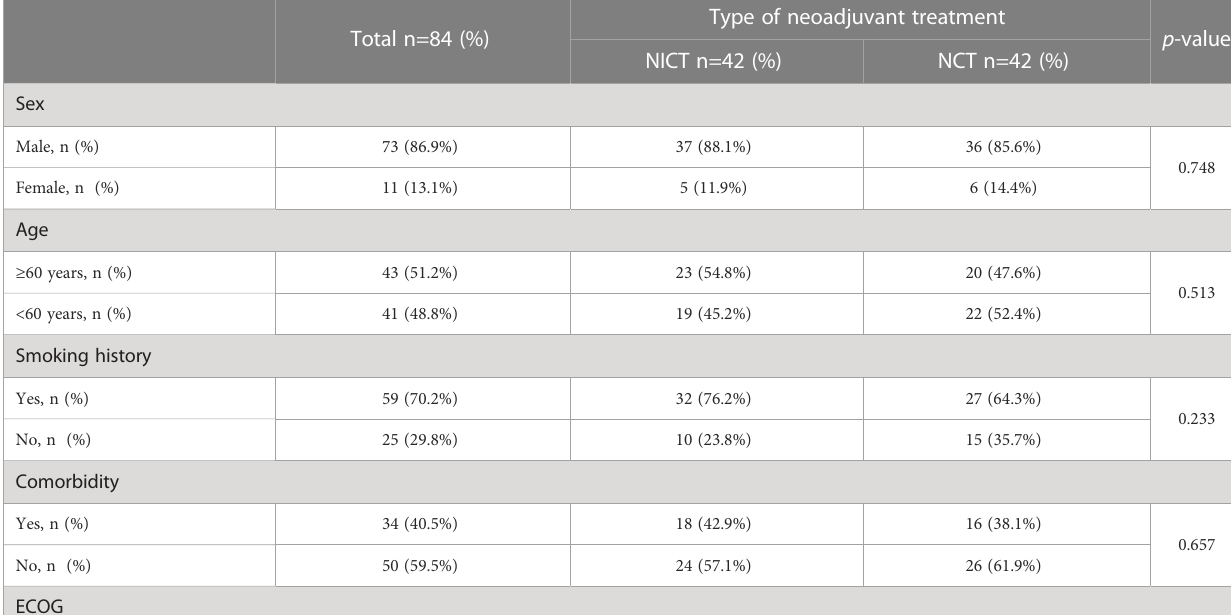
TABLE 2 Baseline clinical and sociodemographic characteristics of patients after PSM. Type of neoadjuvant Total n=84 (%)